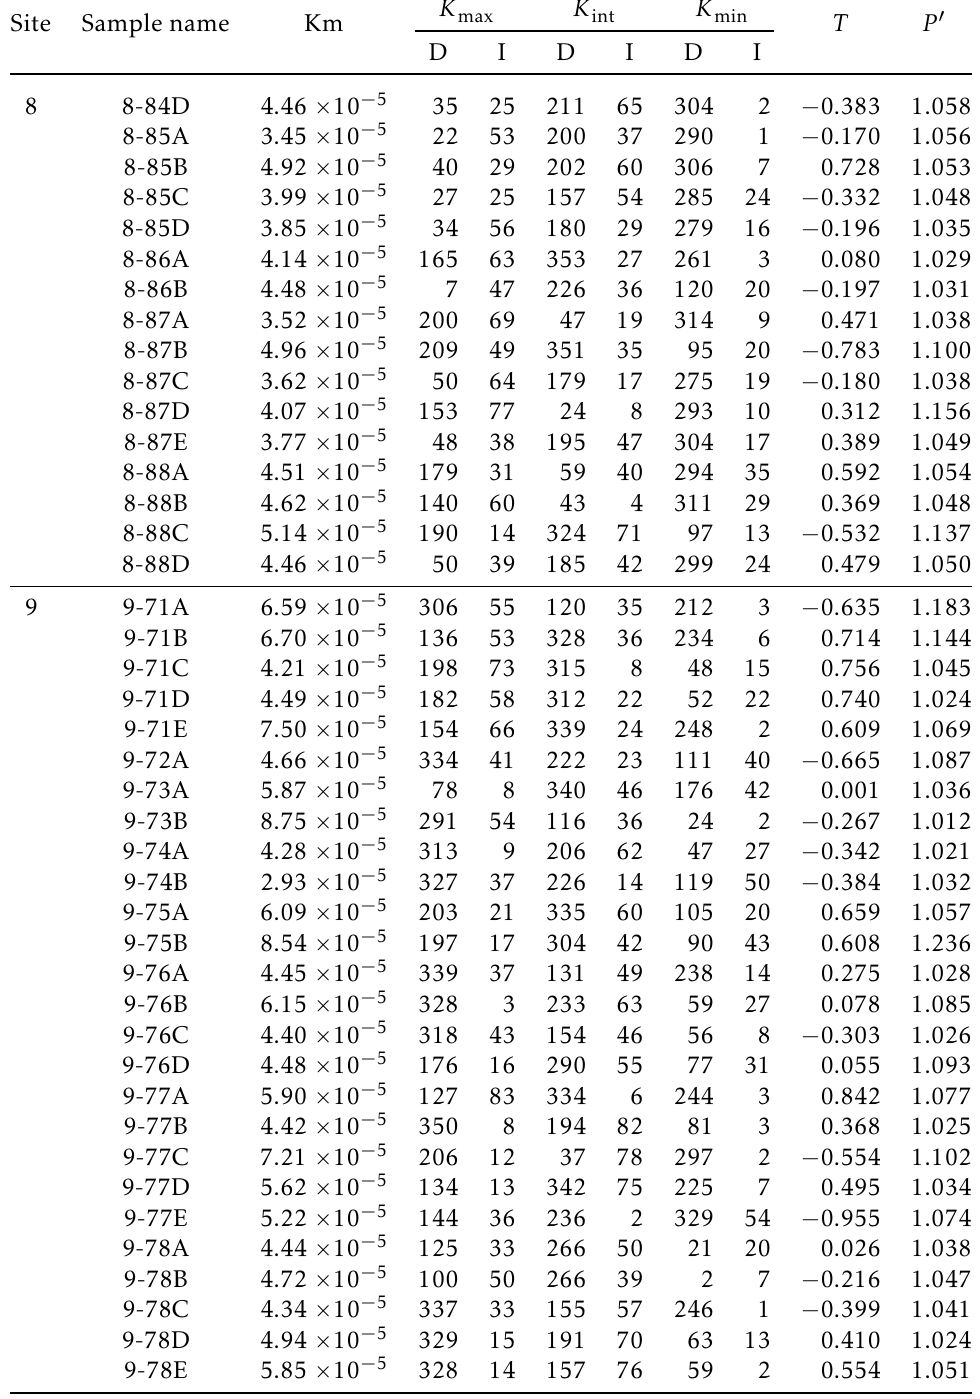
Table A1 [cont.]: Values (Km, in SI) and Directions (D = Declination, I = Inclination, in degrees °) of the principal susceptibilities ( K , K , and K ) of samples from Shiroyama lava; T : shape parameter ( T > 0 oblate, T < 0 max int min : degree of prolate); P 1